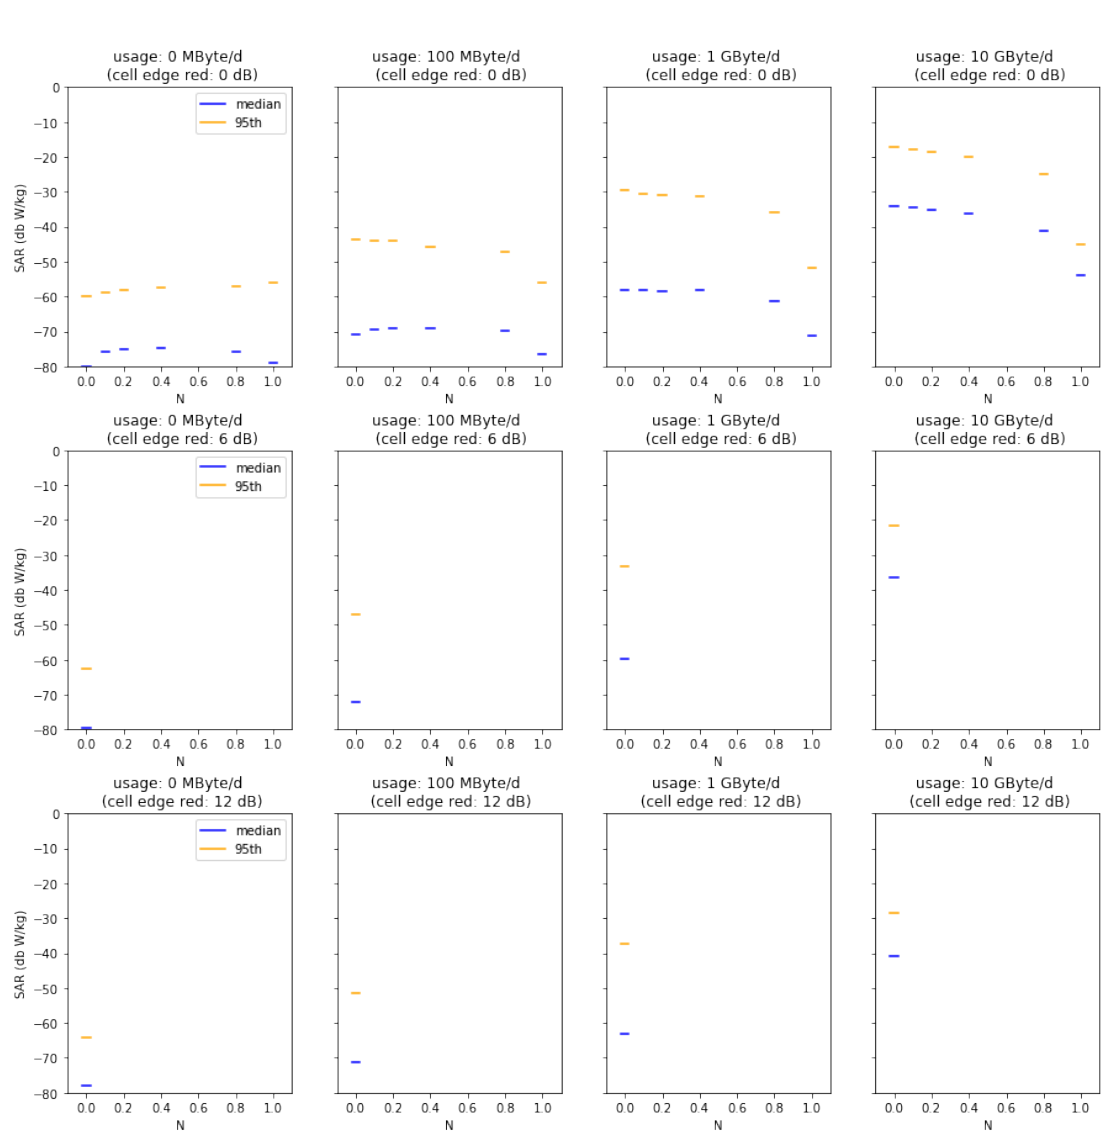
Figure A3. Median and 95th percentiles for varied usage, indoor coverage factor N , and cell size reductions in the urban-macro cell